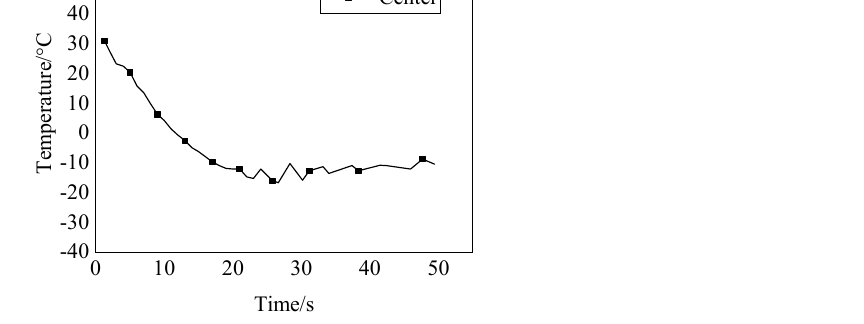
Figure 16. Temperature change curve with time in response phase under 6200 W/m 2 heat flux. Table 8. Experimental data of three stages under 6200 W/m 2 heat flux.